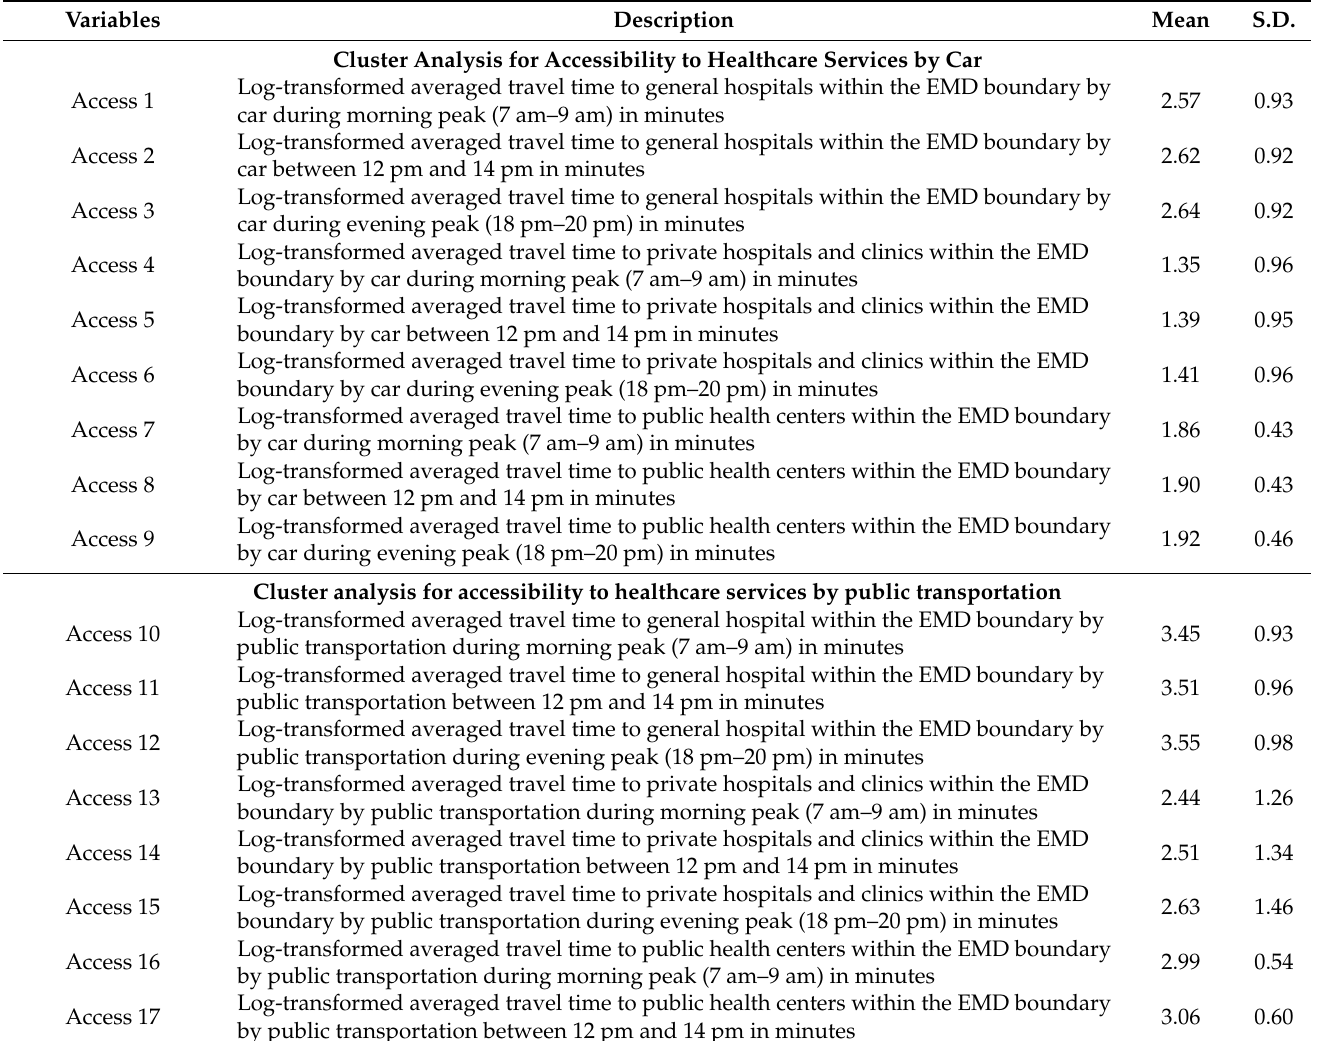
Table 2. Description of Variable Used in Gaussian Mixture